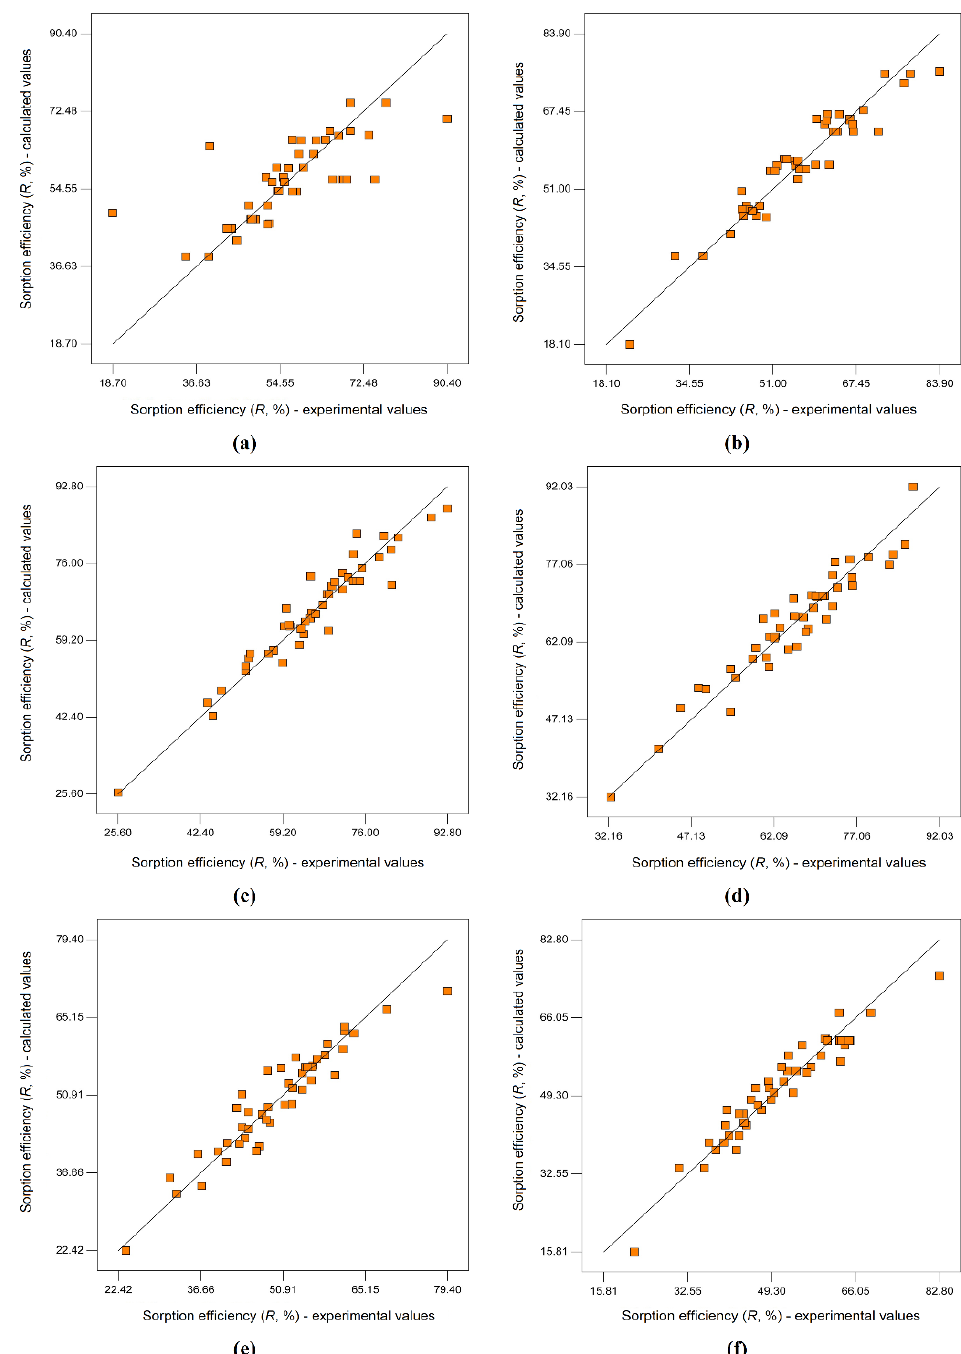
Figure 9. Graphical representation of the concordance between experimental and calculated (pre- dicted) values using the mathematical models developed for biosorption efficiency ( R , %) of Pb(II), Cd(II), and Zn(II) on soybean biomass and soybean waste biomass: ( a ) Pb(II) on soybean biomass; ( b ) Pb(II) on soybean waste biomass; ( c ) Cd(II) on soybean biomass; ( d ) Cd(II) on soybean waste biomass; ( e ) Zn(II) on soybean biomass; ( f ) Zn(II) on soybean waste biomass. To verify the collinearity/multicollinearity of the independent variables (possibly the overestimation of the correlation or determination coefficient as well as the dispersion of the estimated coefficients), the tolerance of the variables x i was tested by the relation (4) and the variance inflation factor, denoted by VIF (relation 5), which shows the extent to which the variance of the model coefficients may increase due to the lack of orthogonality (multicollinearity) of the independent variables.